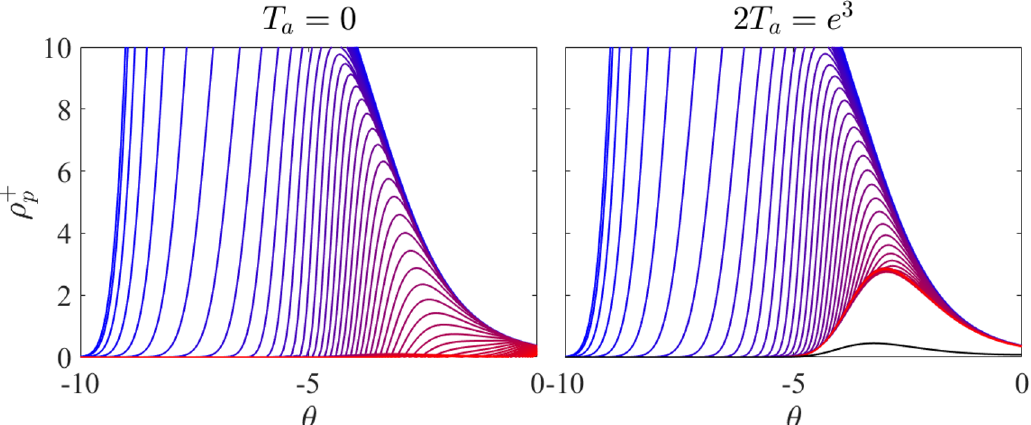
( t, t, θ ? ) across the subsidiary peak in the plane x = t for p = 7 . 5 and no bath (left) or α = 3 (right). m a